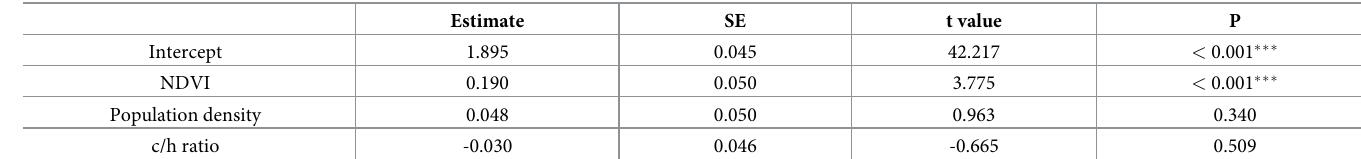
Table 1. Results of model 1 for the response variable FN content and the covariates NDVI in spring-summer, population density and calves/hind ratio.